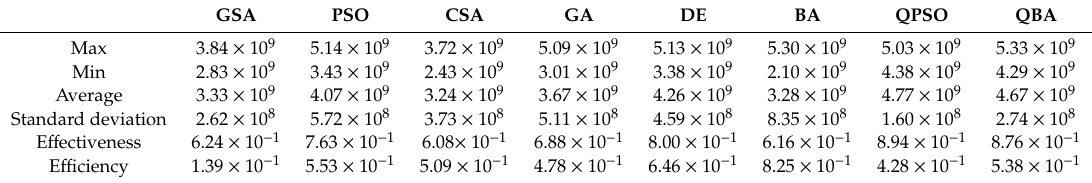
Table 4. Statistical data of applied metaheuristic algorithms on well placement optimization for case study 1.